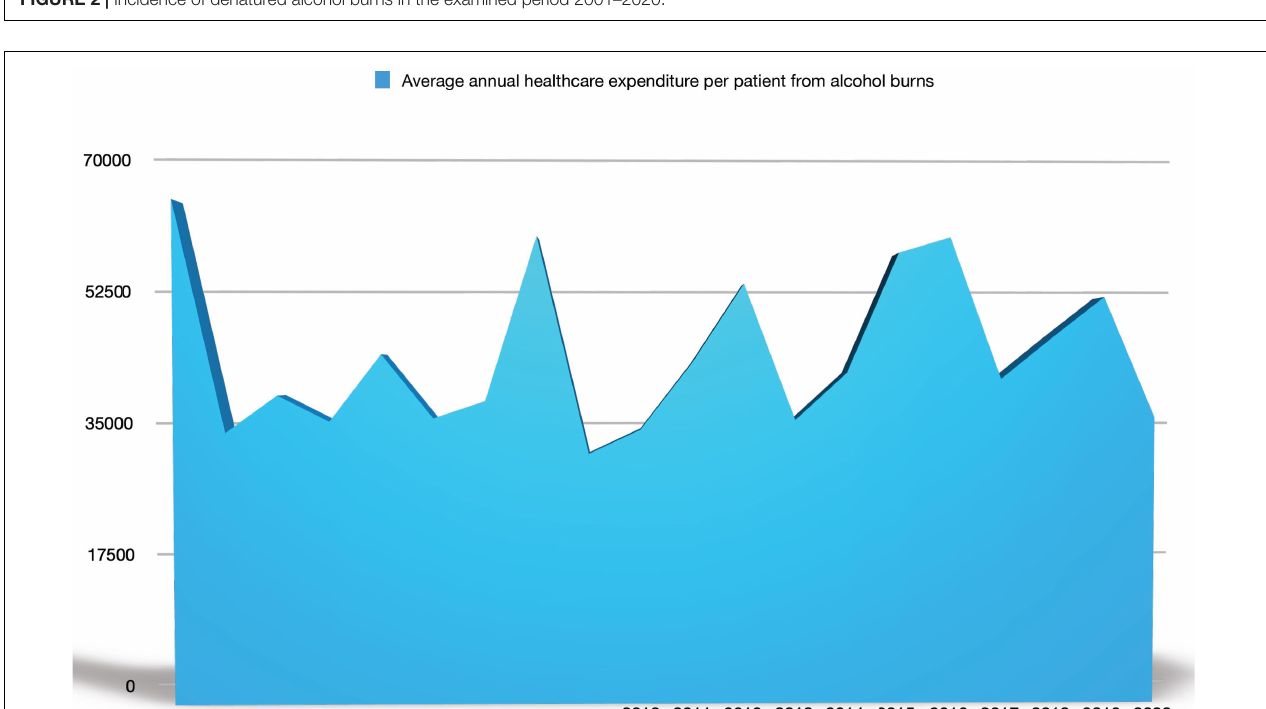
FIGURE 2 | Incidence of denatured alcohol burns in the examined period 2001–2020.